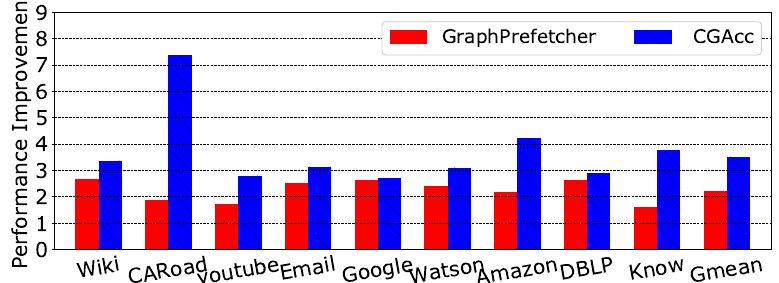
Figure 12. Comparison of the performance on a few benchmarks between graph prefetcher and CGAcc.